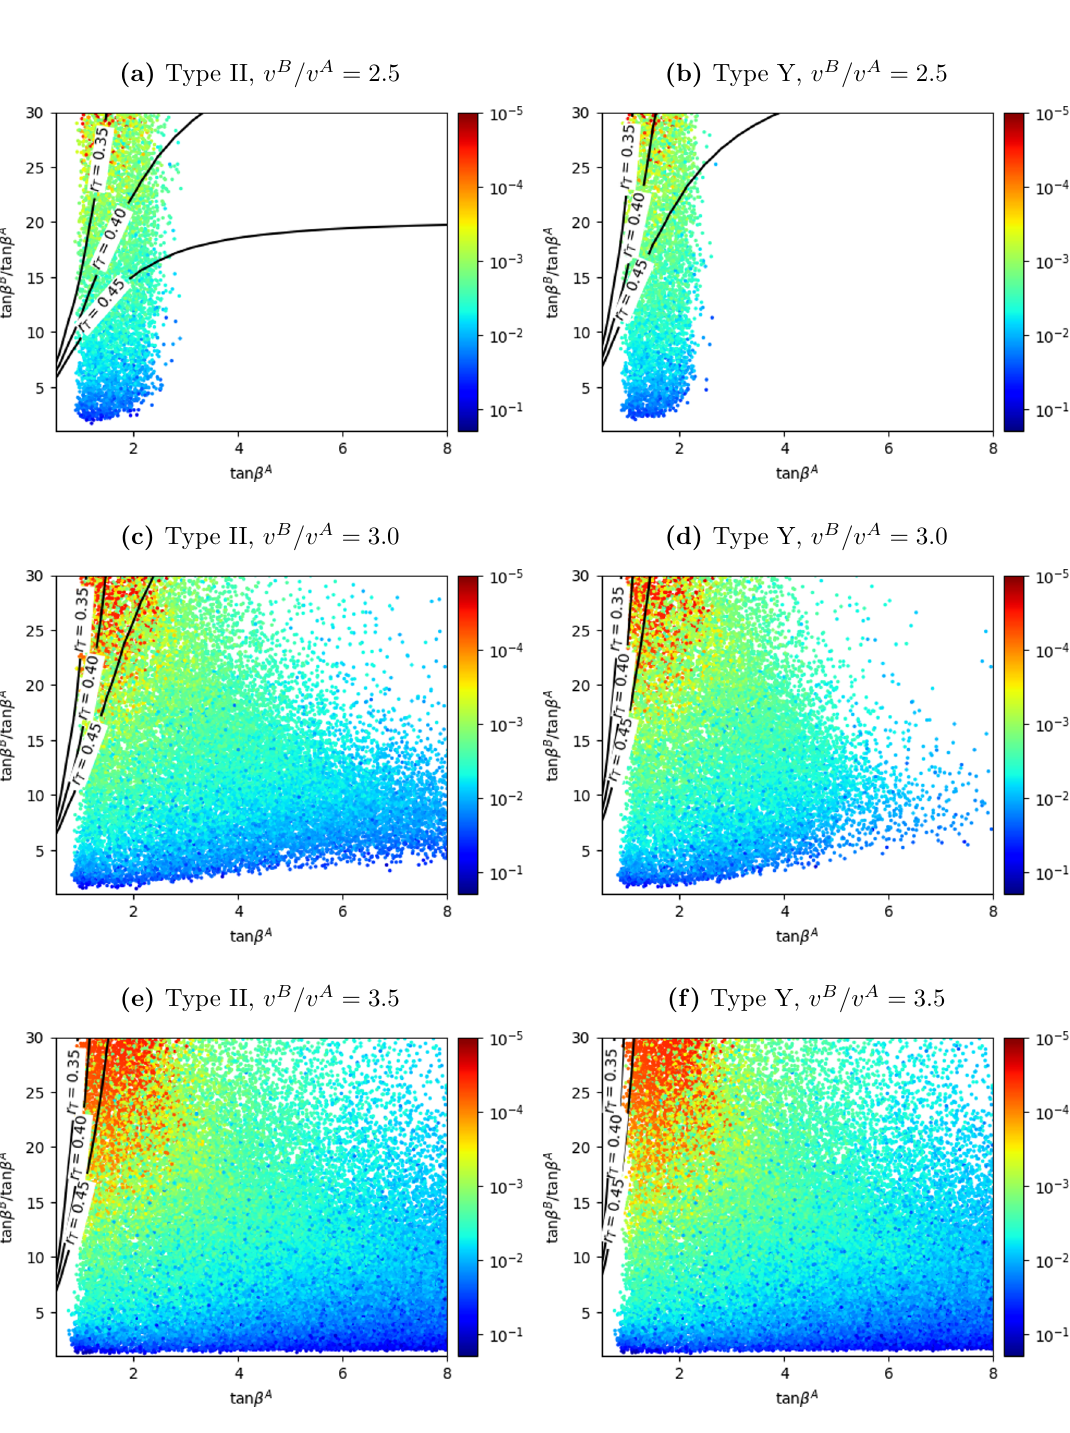
Figure 3. Contours of X DA = 10% for di(cid:11)erent r T , di(cid:11)erent v B =v A , di(cid:11)erent types and m = 2 : 16 MeV. The colour corresponds to the minimum of T (cid:18) u A